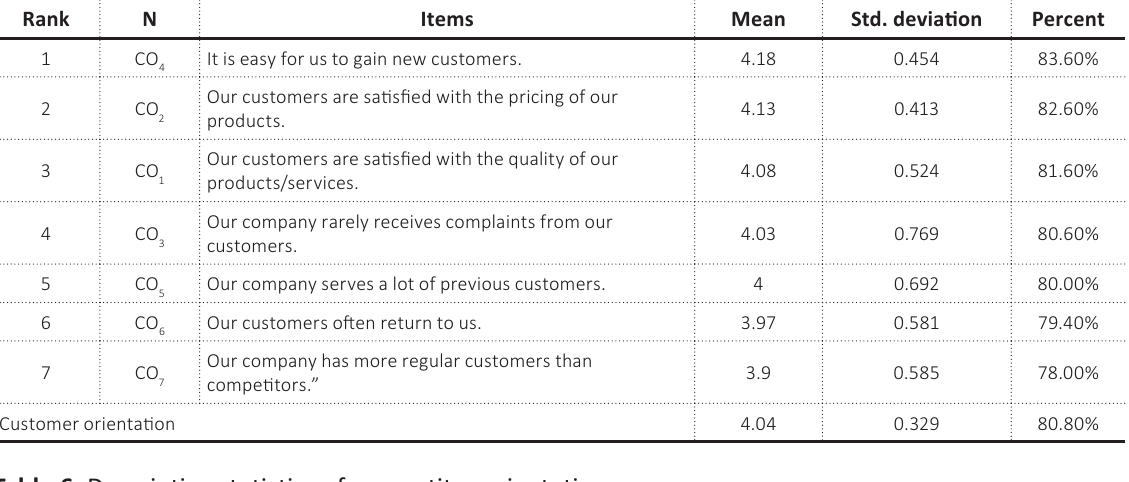
Table 6. Descriptive statistics of competitor orientation